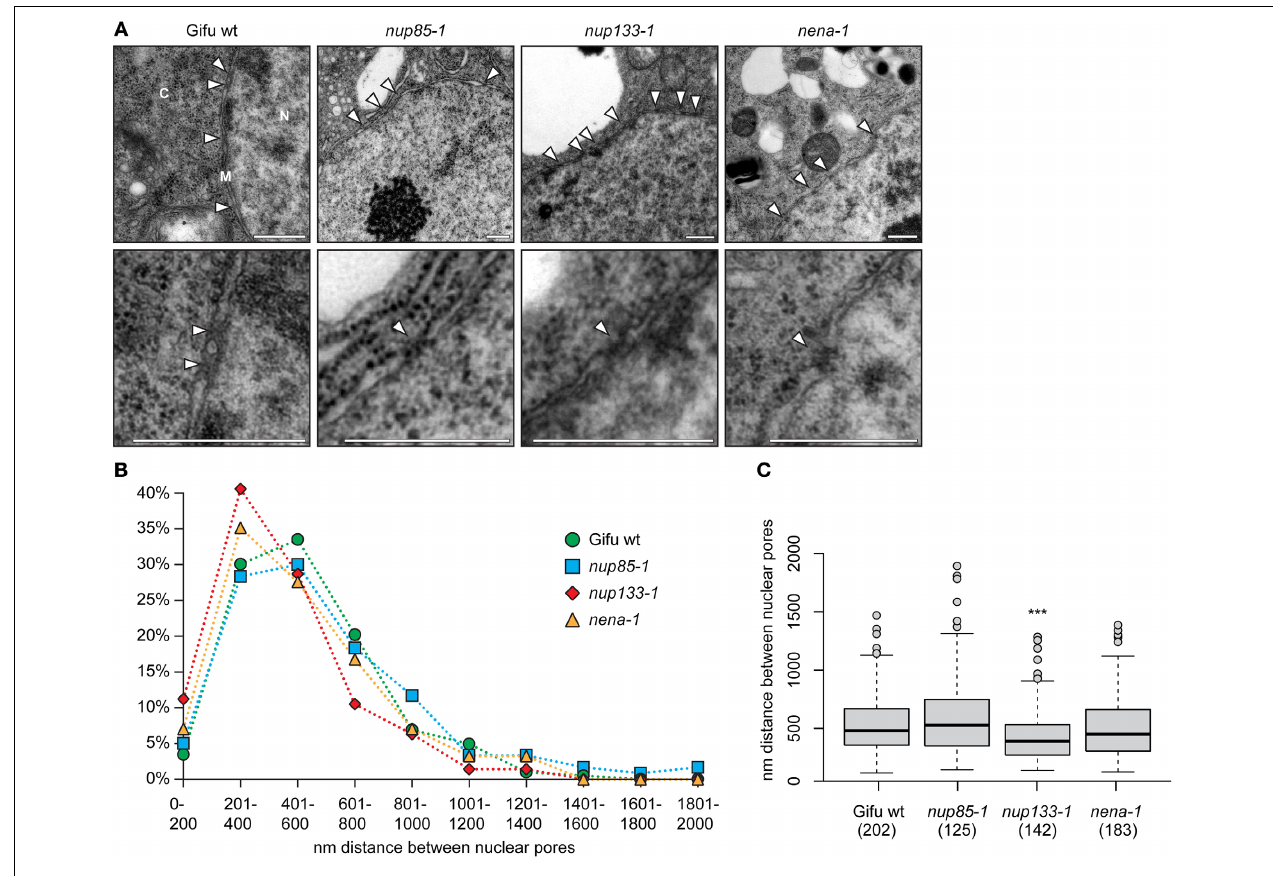
FIGURE 2 | NPC distance distribution. (A) TEM micrographs of ultrathin sections of L. japonicus root tips (N, nucleus; C, cytosol; M, nuclear membranes). White arrow heads indicate the position of nuclear pores. The lower images show a magnified view of individual pores. Scale bar = 500nm. (B) Distance distribution between adjacent NPCs. (C) Box plot showing NPC distances.